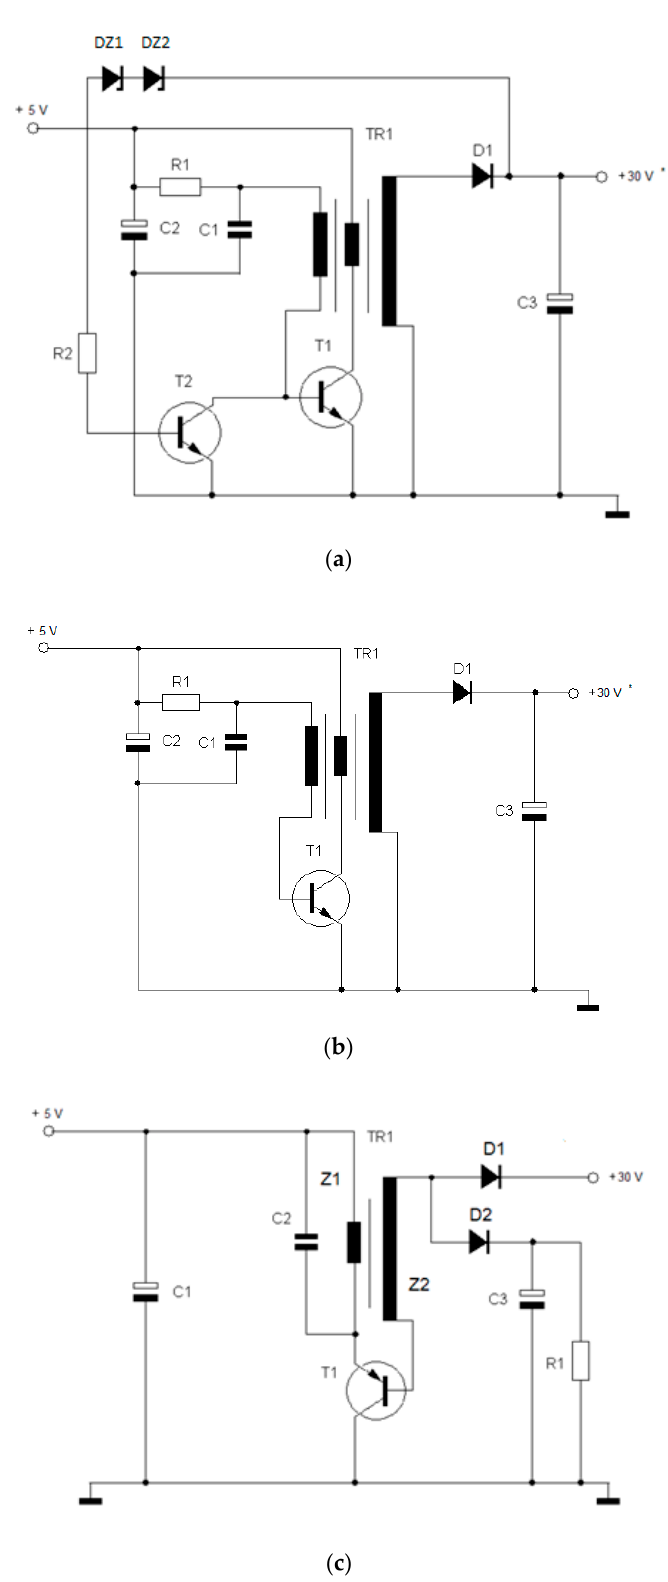
Figure 8. Scheme of step-up converters: ( a ) in a self-regulating generator system with output voltage stabilization, ( b ) without stabilization system, ( c ) “Optimal” step-up converter, where C1, C2, C3 are capacitors; DZ1, DZ2 are Zener diodes; Z1, Z2, Z3 are windings; D1, D2, D3 are Schottky diodes; R1 it is resistor; T1 is transistor; TR1 is